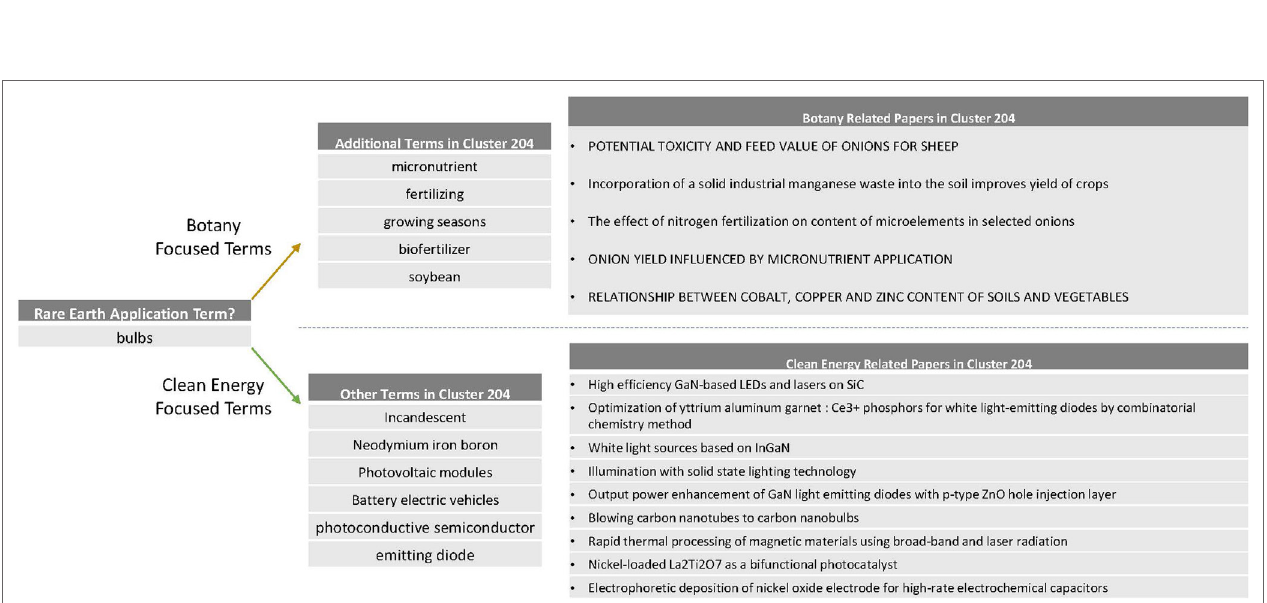
FigUre 4 | The coclustering algorithm produced term clusters. This is an example of an unfocused cluster that spans basic science research and non-clean energy research.